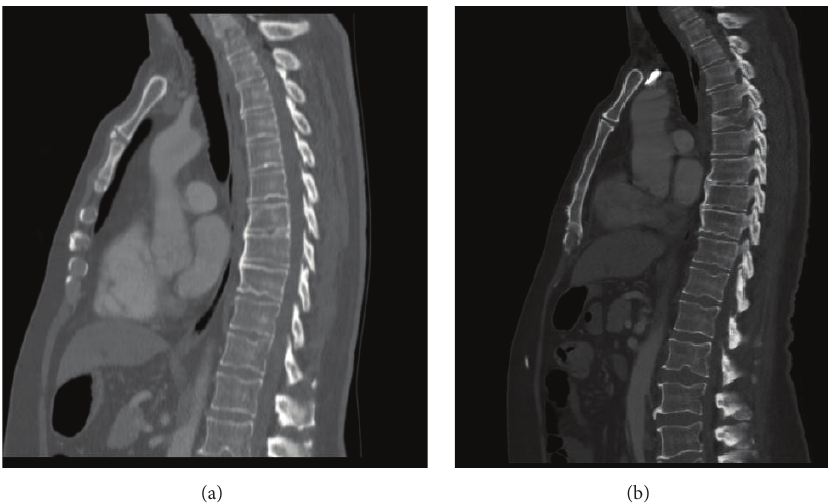
Figure 1: (a) CT scan at the time of penile resection. (b) CT scan at the time of A+E presentation with weakness.